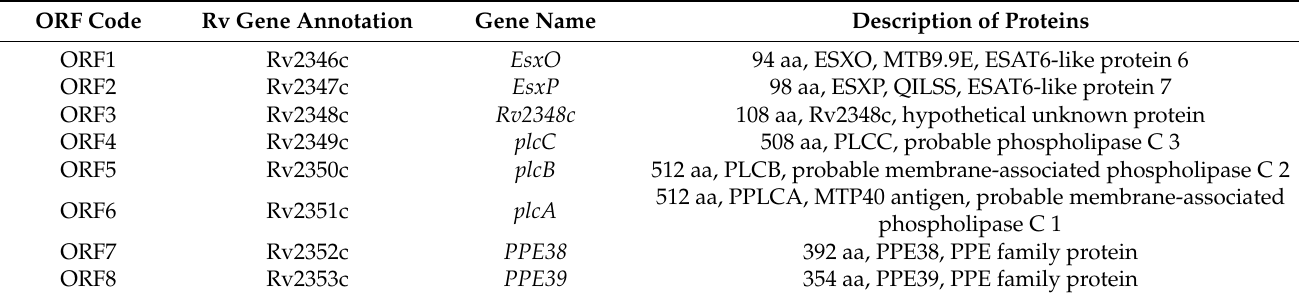
Table 3. Open reading frame (ORF) code, gene annotation, gene name and description of proteins encoded by genes in RD7. ORF